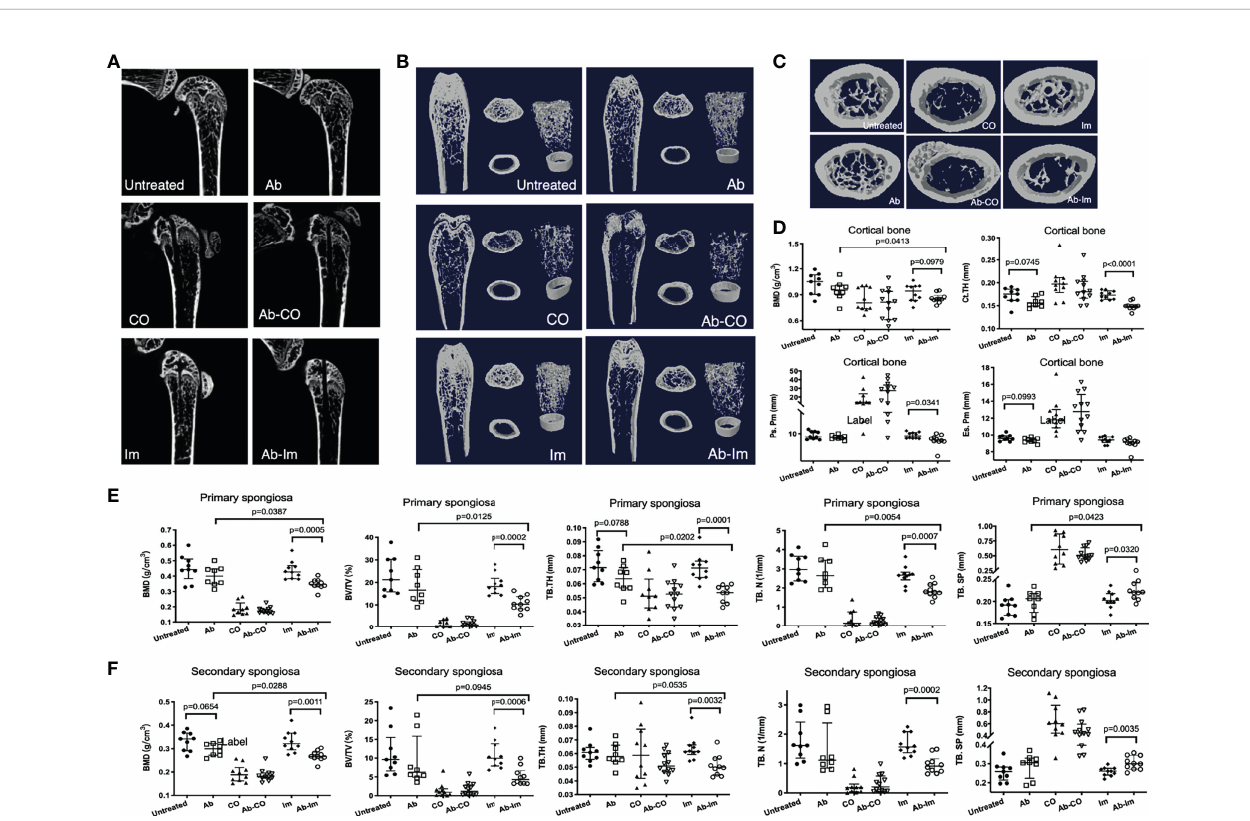
FIGURE 2 | Antibiotic-induced dysregulation of gut microbiota reduced BMD. Distal femoral specimens were harvested and analyzed at 4 weeks postsurgery from mice. Micro-CT analyses were conducted of the trabecular and cortical bone of the distal femur in mice from each group. (A) Representative reconstructed 2D sagittal images of the distal femur. (B) Representative reconstructed images of the trabecular and cortical bone. Left: coronal plane; Middle: cross-section at the level of the primary spongiosa (upper, extending 0.3 – 1.3 mm proximally from the distal metaphyseal growth plate) and cortical bone (bottom, extending 4 – 4.8 mm proximally from the distal metaphyseal growth plate); Right: 3D reconstruction of the trabecular and cortical bone. (C) Representative reconstructed cross-sectional images of trabecular bone of the second spongiosa (extending 1.3 – 3.3 mm proximally from the distal metaphyseal growth plate). (D) Characteristics of the cortical bone (n=9) including BMD, cortical thickness (Ct.Th), periosteal perimeter (Ps.Pm), and endosteal perimeter (Es.Pm). (E) Characteristics of the primary spongiosa (n=9) including BMD, bone volume fraction (BV/TV), trabecular thickness (Tb.Th), trabecular number (Tb.N), and trabecular separation (Tb.Sp). (F) Characteristics of the secondary spongiosa (n=9) including BMD, BV/TV, Tb.Th, Tb.N, and Tb.Sp. All data are shown as the median and interquartile range, analyzed by unpaired t - test between untreated and Ab, Ab-CO and CO, or between Ab-Im and Im